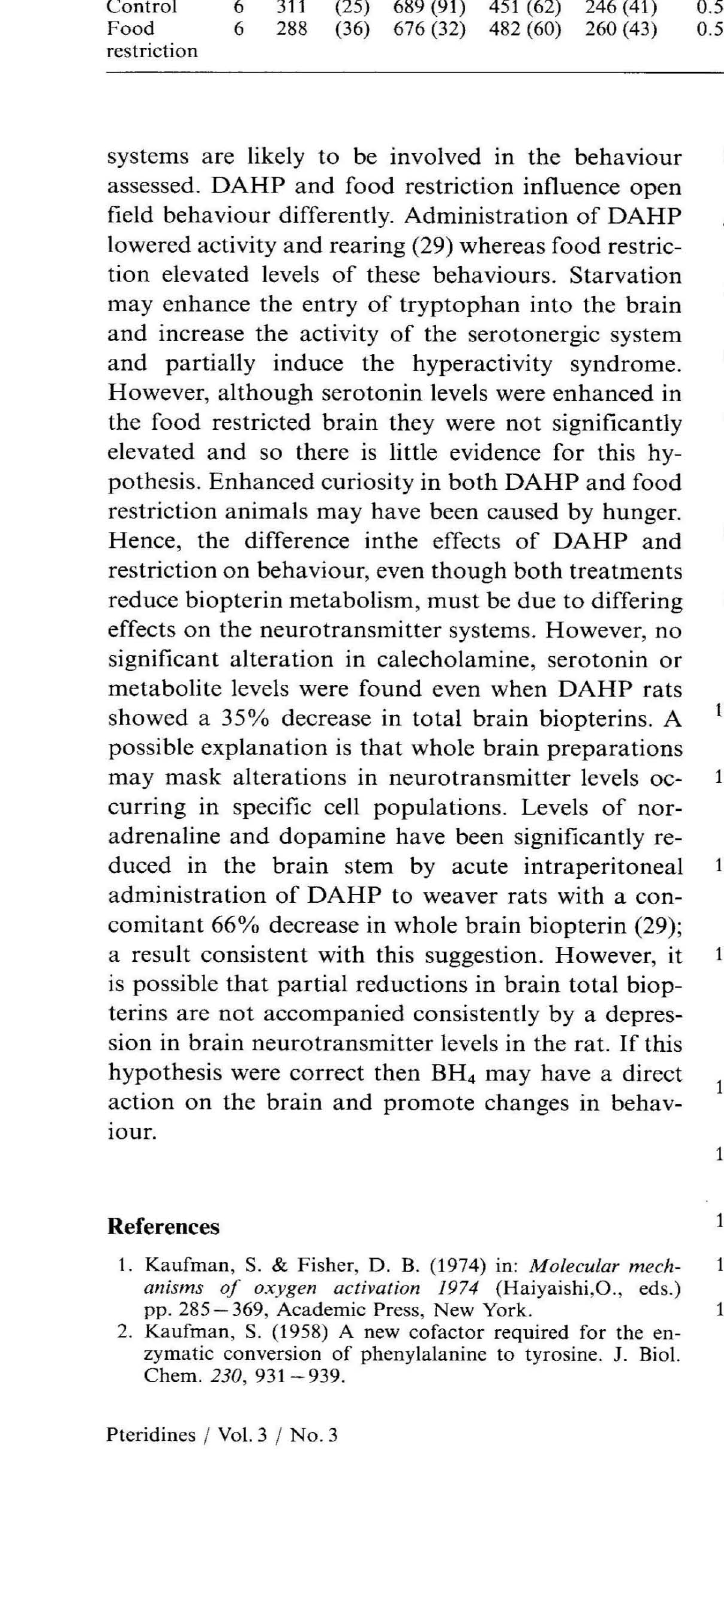
Table 3. The influence of 5% DAHP and food restriction on the levels of noradrenaline (NA), dopamine (DA), serotonin (5HT), 5-Hydroxyindoleacetic acid (5-HIAA), 5-HIAA: 5-HT (ng g-l wet weight) and animal behaviour (n = number of animals, standard deviation indicated in parentheses; data are values of X 2 from contingency tests and arrows indicate increase or decrease in parameter c/w control * P < 0.05, *** P <